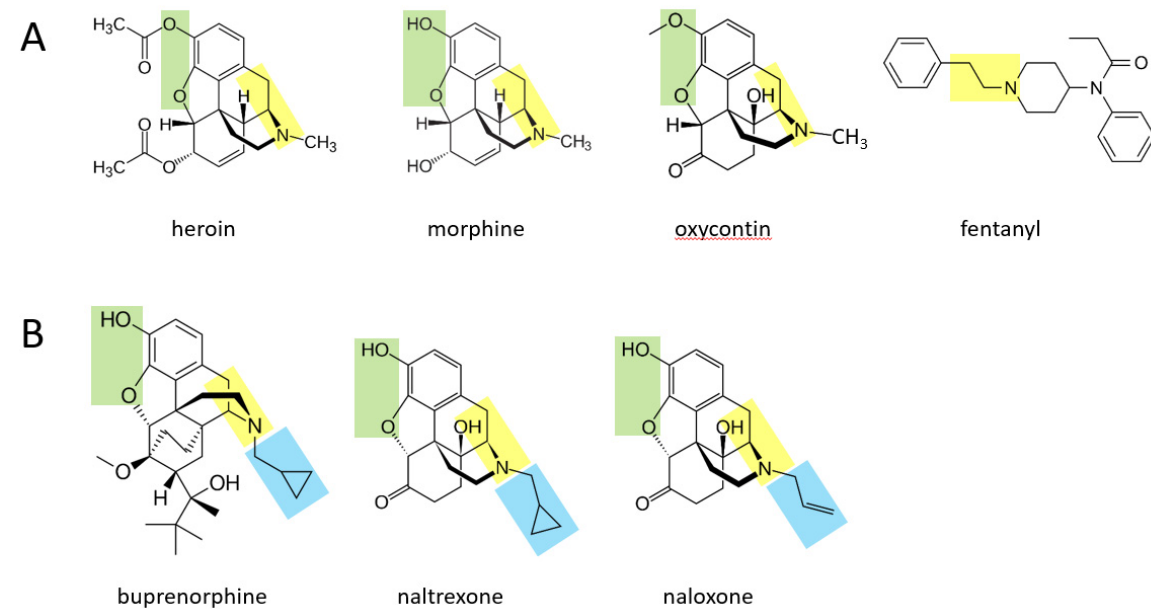
Figure 2. A number of opioids could be transformed to catecholamines in the body. ( A ) These drugs of abuse possess moieties, marked in yellow or green, that may allow them to be converted to catecholamines acutely. ( B ) Compounds used to treat opioid abuse, in contrast, possess an additional moiety (light blue) that may block them from being fully converted to catecholamines and may allow them to serve as a pharmacological blocker of the endogenous pathways acted upon by the four drugs in ( A ).